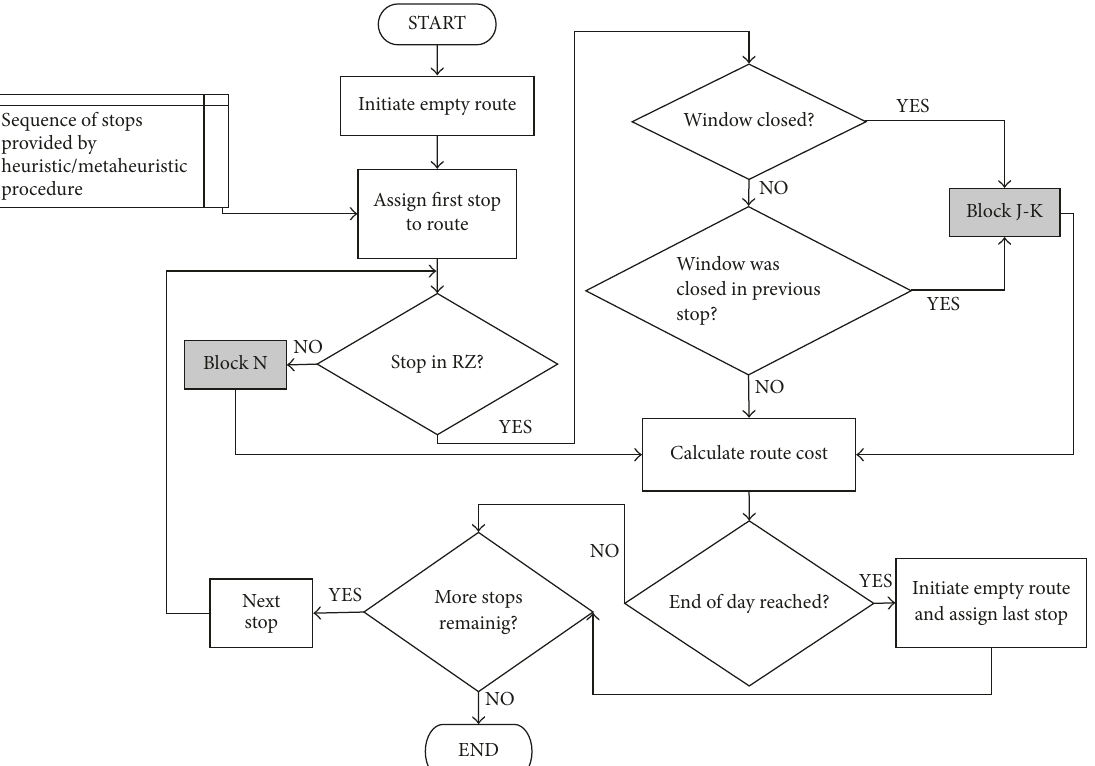
Figure 5: Schematic representation of the evaluation process for the fitness function used in the three soft-computing